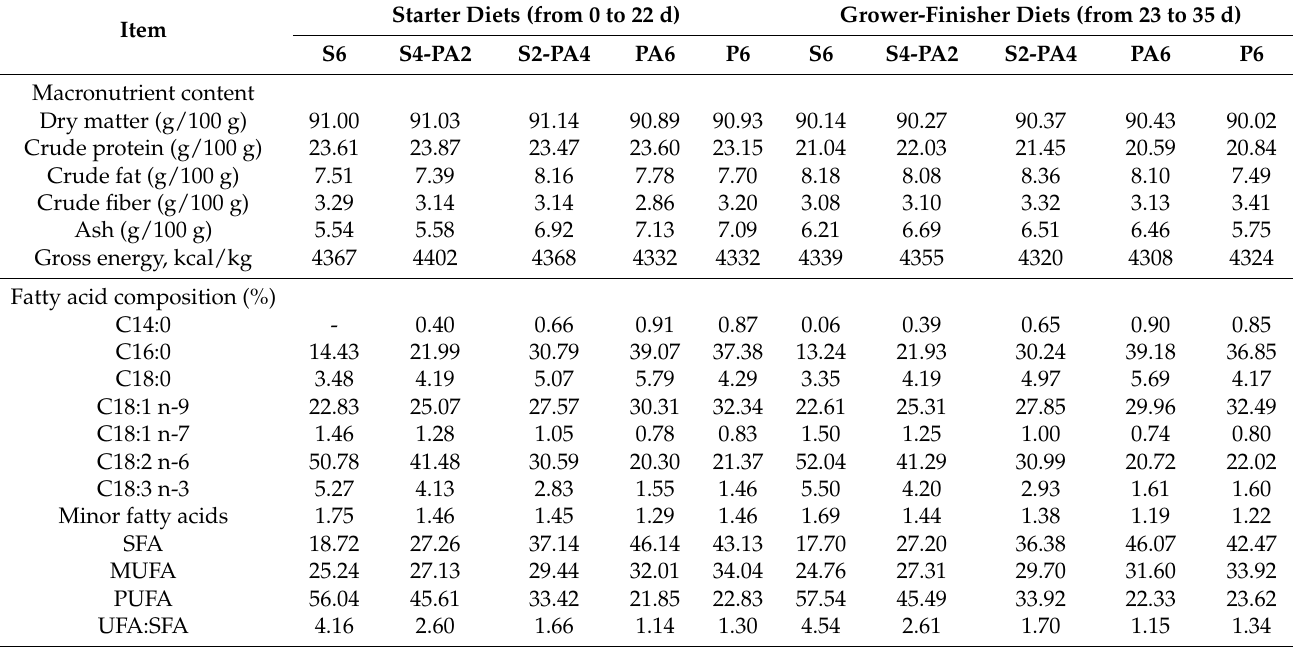
Table 3. Analyzed 1 macronutrient content and fatty-acid and lipid-class composition of the experimental diets 2